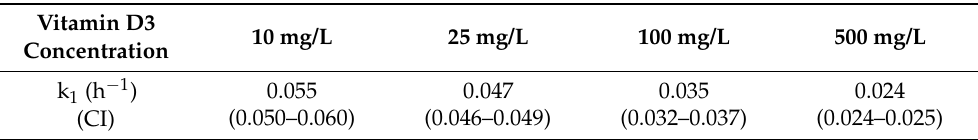
Table 5. First-order rate constants for vitamin D3 at different concentrations in Milli-Q